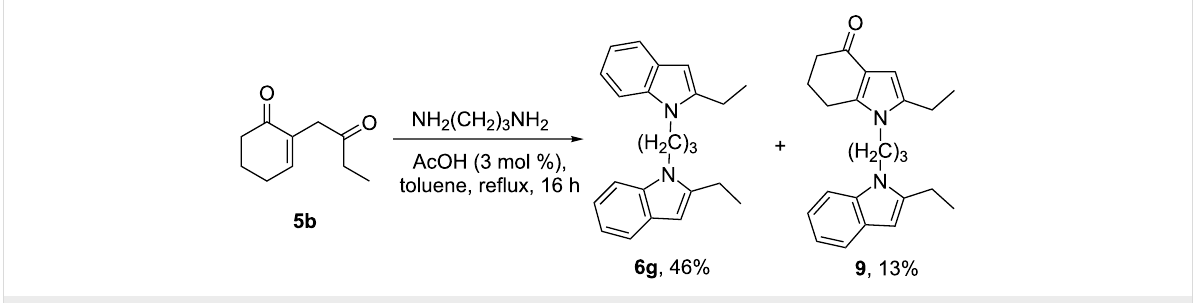
Scheme 5: Reaction of 5b with a